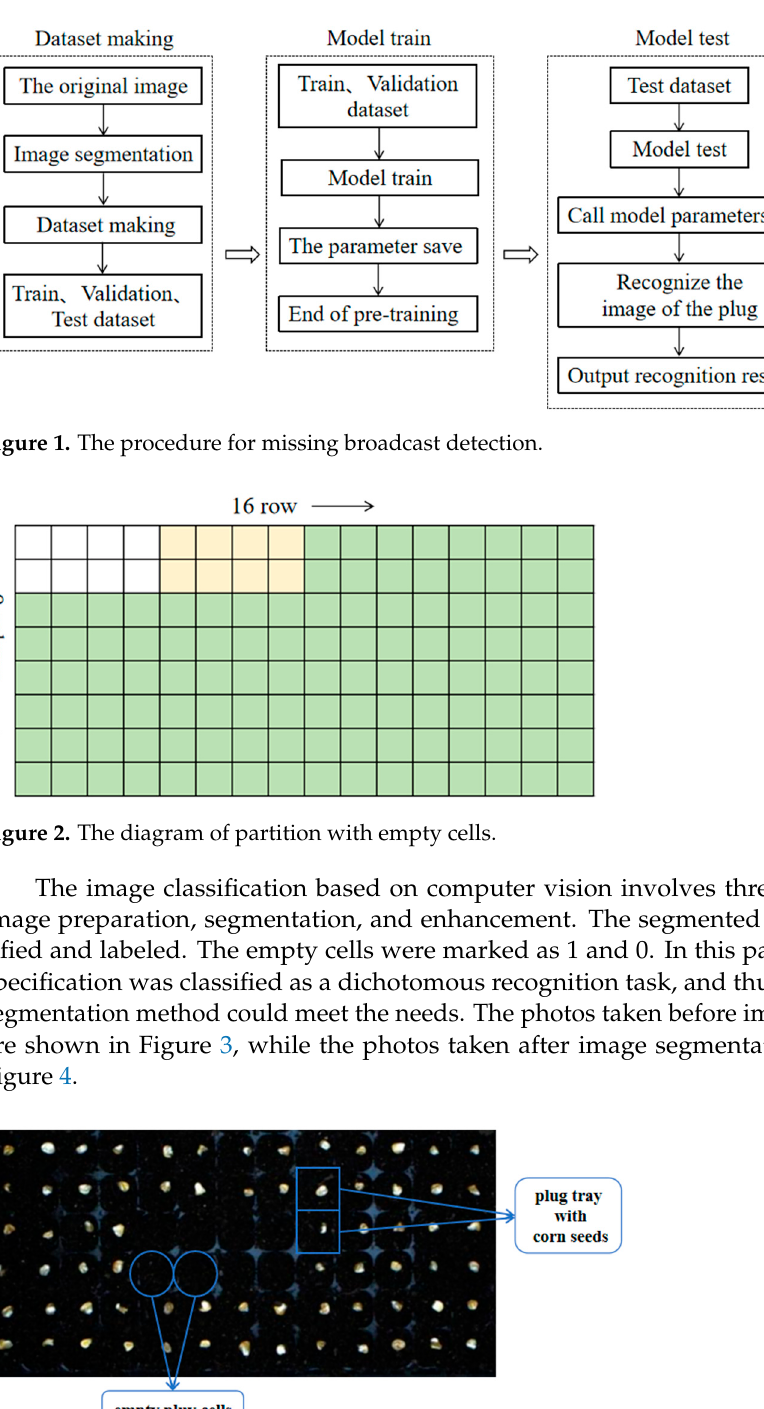
Figure 3. Photos captured before segmentation.